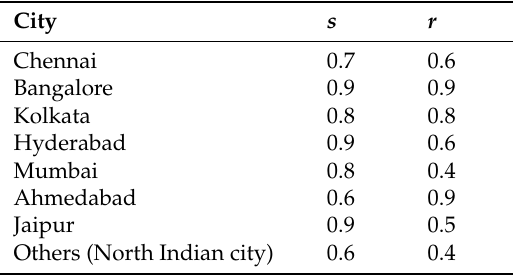
Table 3. Seasonal emission activity SEA values by each city, used for summer s and rain r for residential ( A R ) and commercial ( A C ) emissions. City s